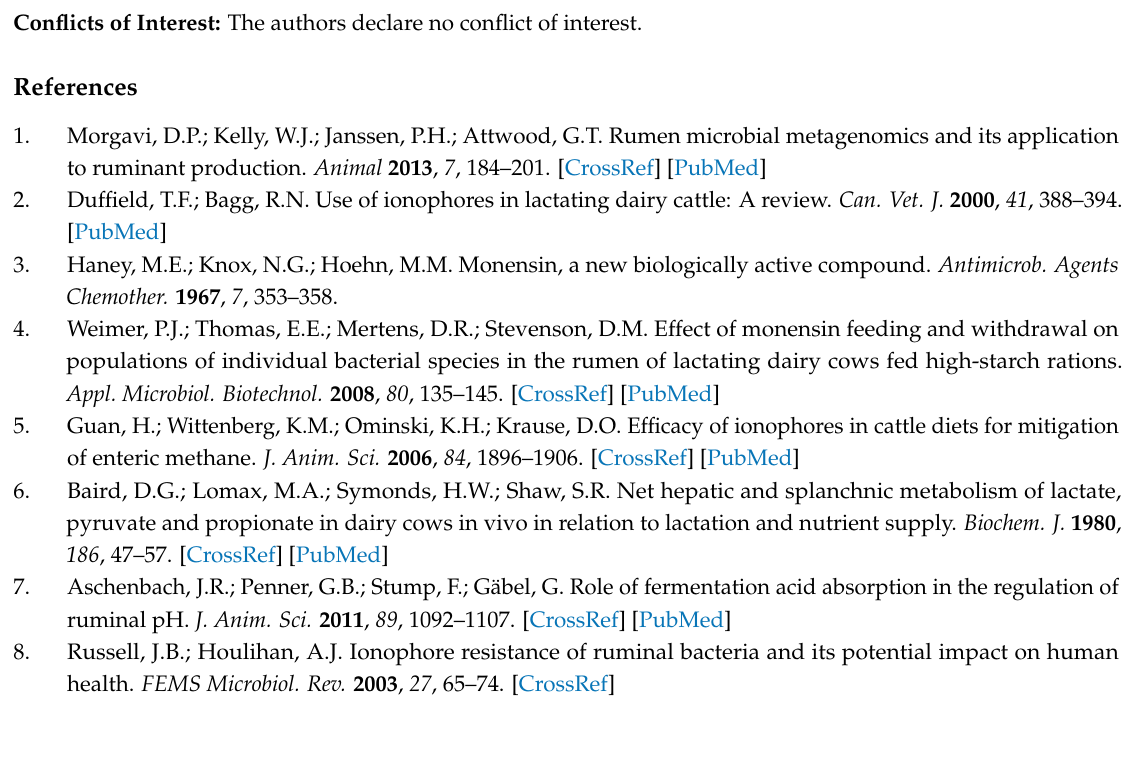
Table S1: Nutritional composition of the diet, Table S2: Average relative abundance of taxa at the genus level, Table S3: Average relative abundance of taxa at the genus level, Table S4: Average relative abundance of taxa at the genus level, Table S5: List of identified metabolites, Figure S1: Rarefaction curve of the 8 samples, Figure S2. The scores scatter plot of the PCA model showing the clustering of the quality control